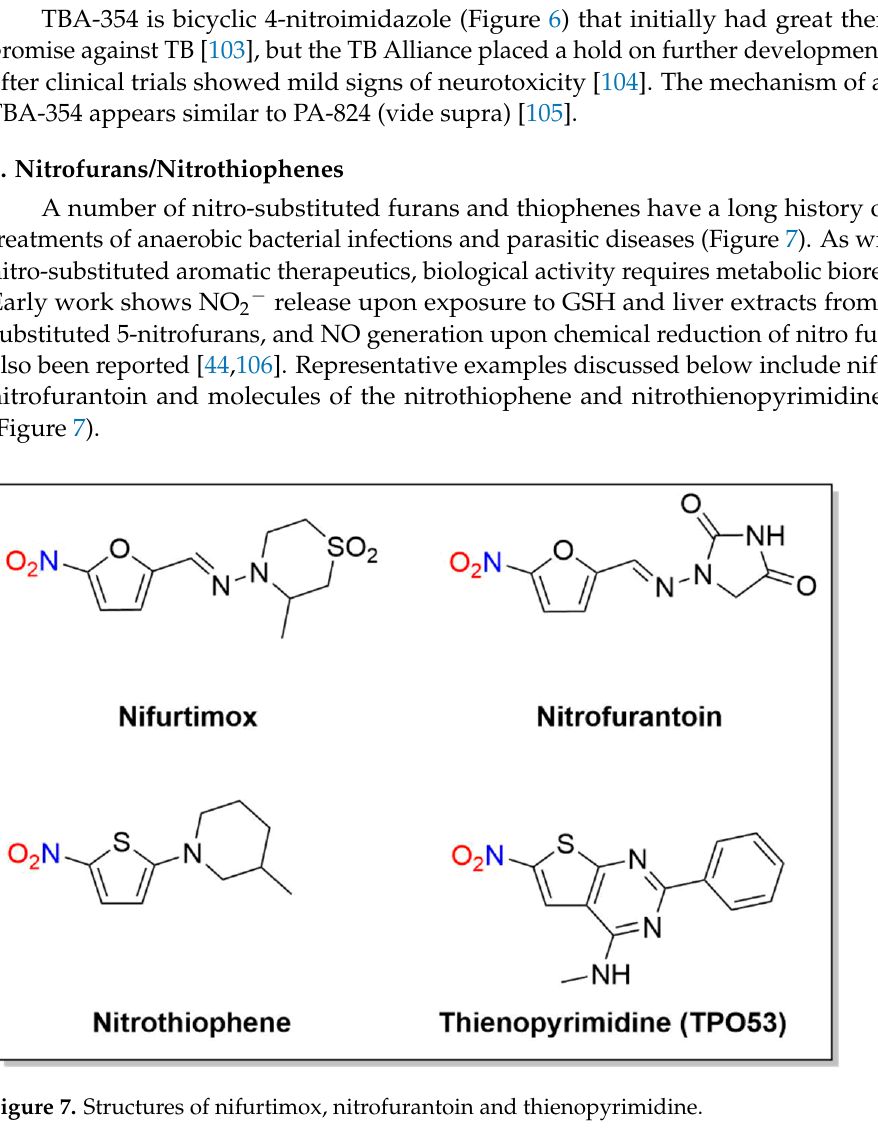
Figure 7. Structures of nifurtimox, nitrofurantoin and thienopyrimidine.